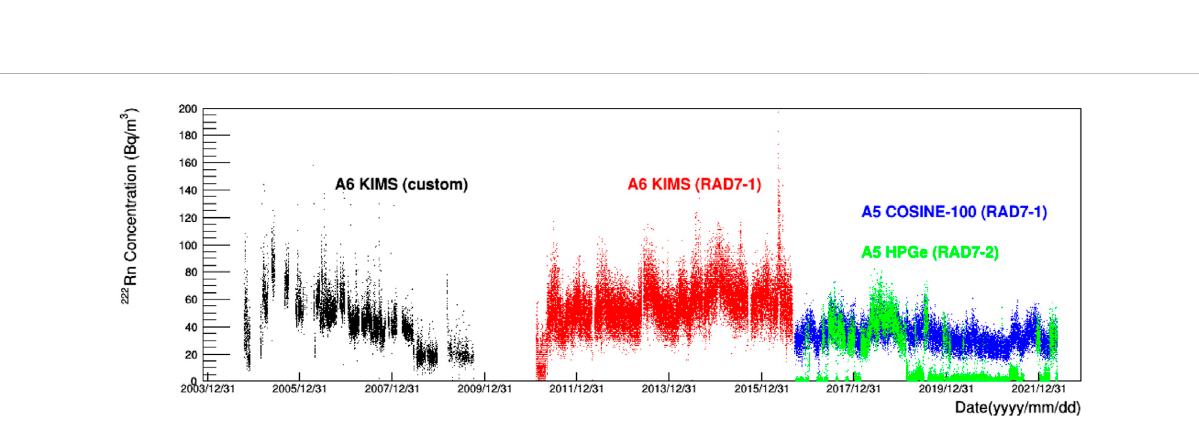
FIGURE 2 The 222 Rn concentration in Y2L between 2004 and 2022 was measured in two different experimental areas. At the KIMS laboratory, the custom detector measurements were recorded between October 2004 to October 2009 (black), whereas the RAD7-1 measurements were recorded between February 2011 and September 2016 (red). The COSINE-100 room data were acquired between September 2016 and May 2022 (blue) with thesameRAD7-1counterandtheHPGeroomdata(RAD7-2)aredisplayedingreenmarkswhichincludedatawhenRRSsystemisrunning.Note that only 10% of all data ditributed evenly throughout the period for the KIMS-Custom measurement is shown. Also note that A6 KIMS (custom) data is from Ref. [29] and half of A5 COSINE-100 data has been previously reported in Ref.